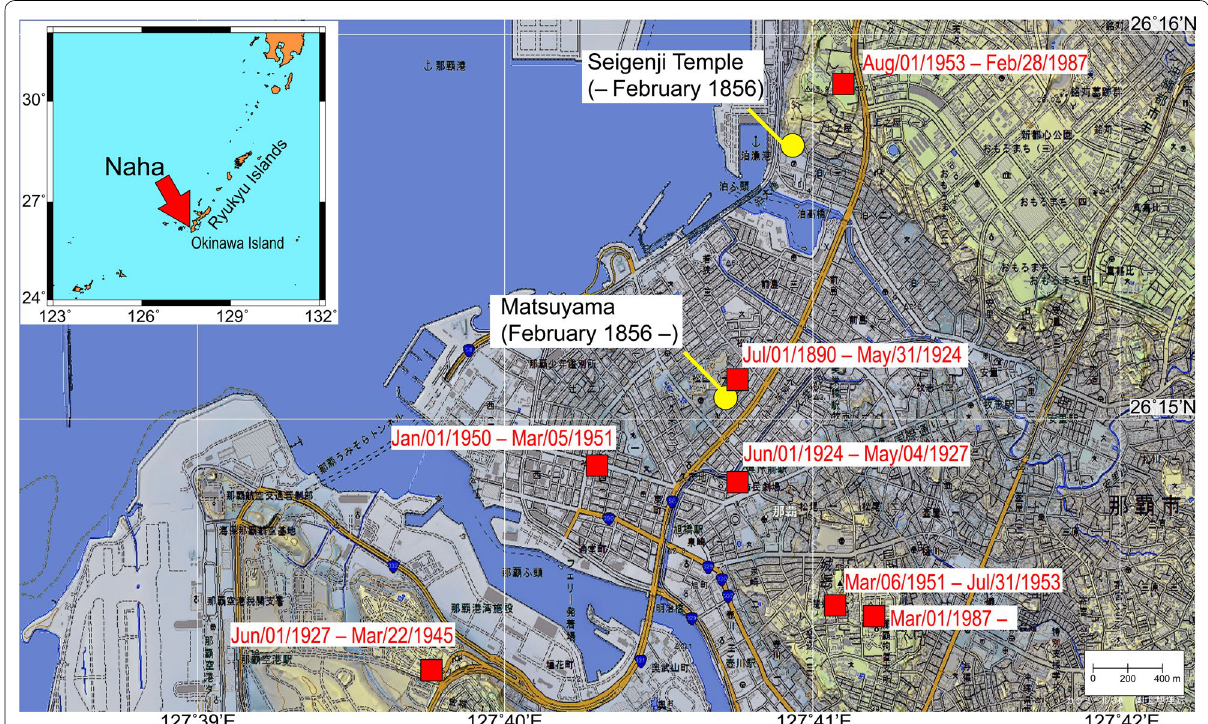
Fig. 1 Map of French residences and JMA intensity observation points in Naha, Okinawa Island. Yellow circles show the French residences. Red rectangles show the JMA intensity observation points. Red annotations denote the observation periods for the JMA points. National Land Numerical Information data provided by the Geospatial Information Authority of